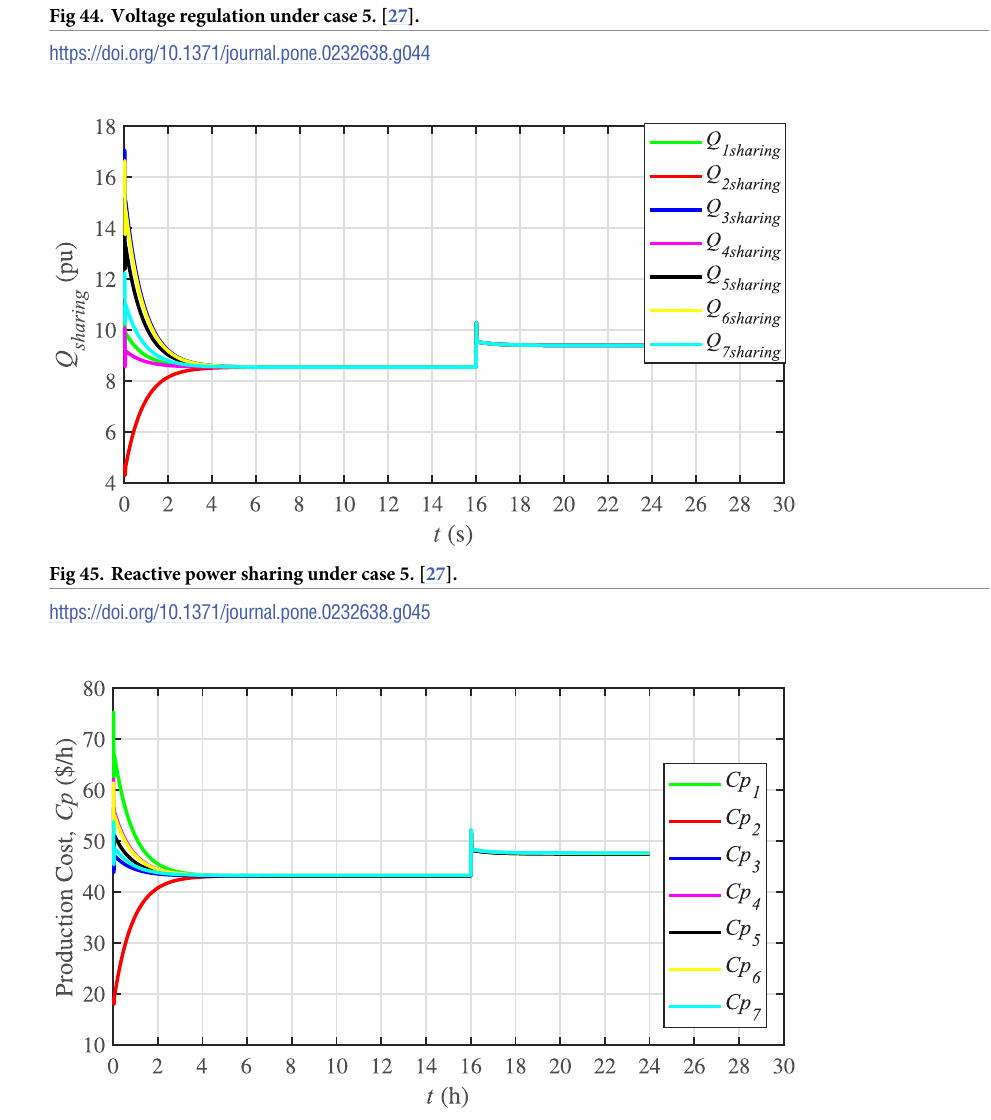
Fig 46. Production cost consensus under case 5. [27].